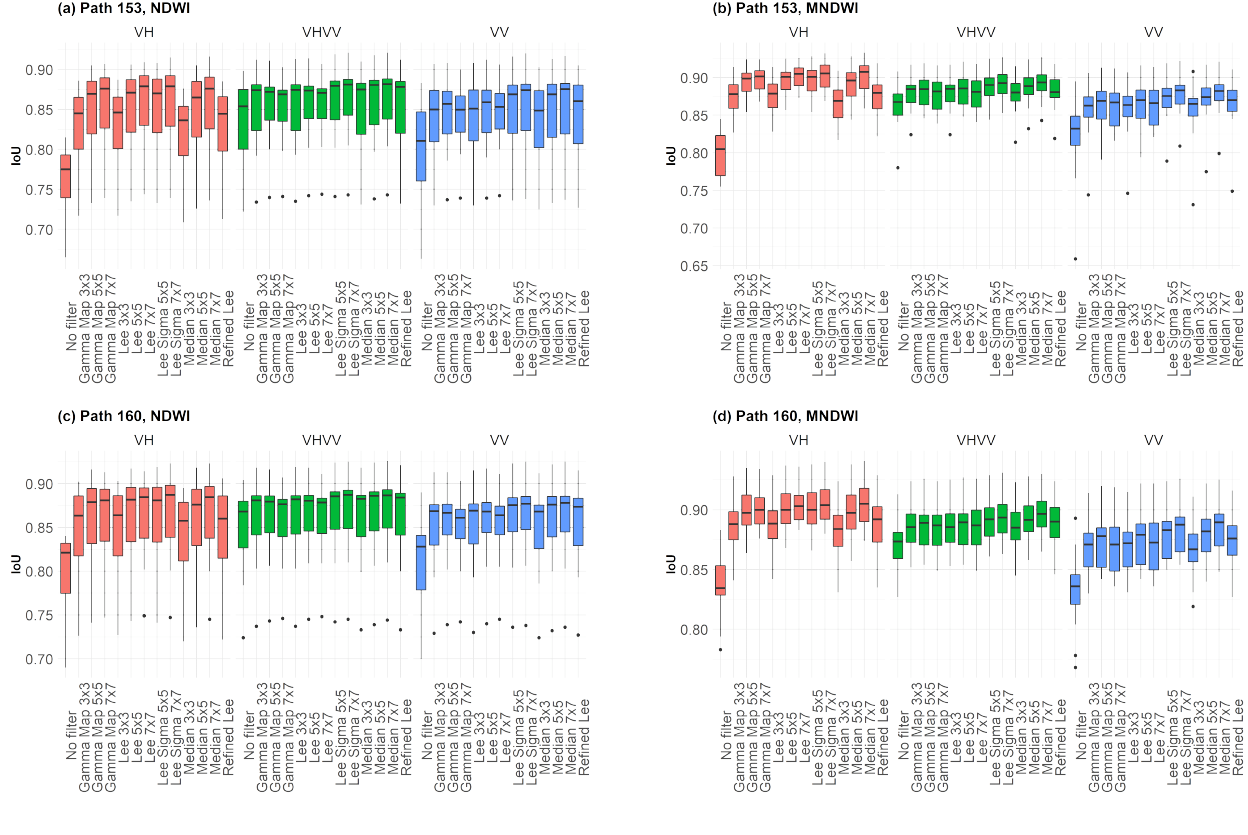
Figure 6. IoU box-plot chart for various reference masks, polarizations, and speckle filtering parame-